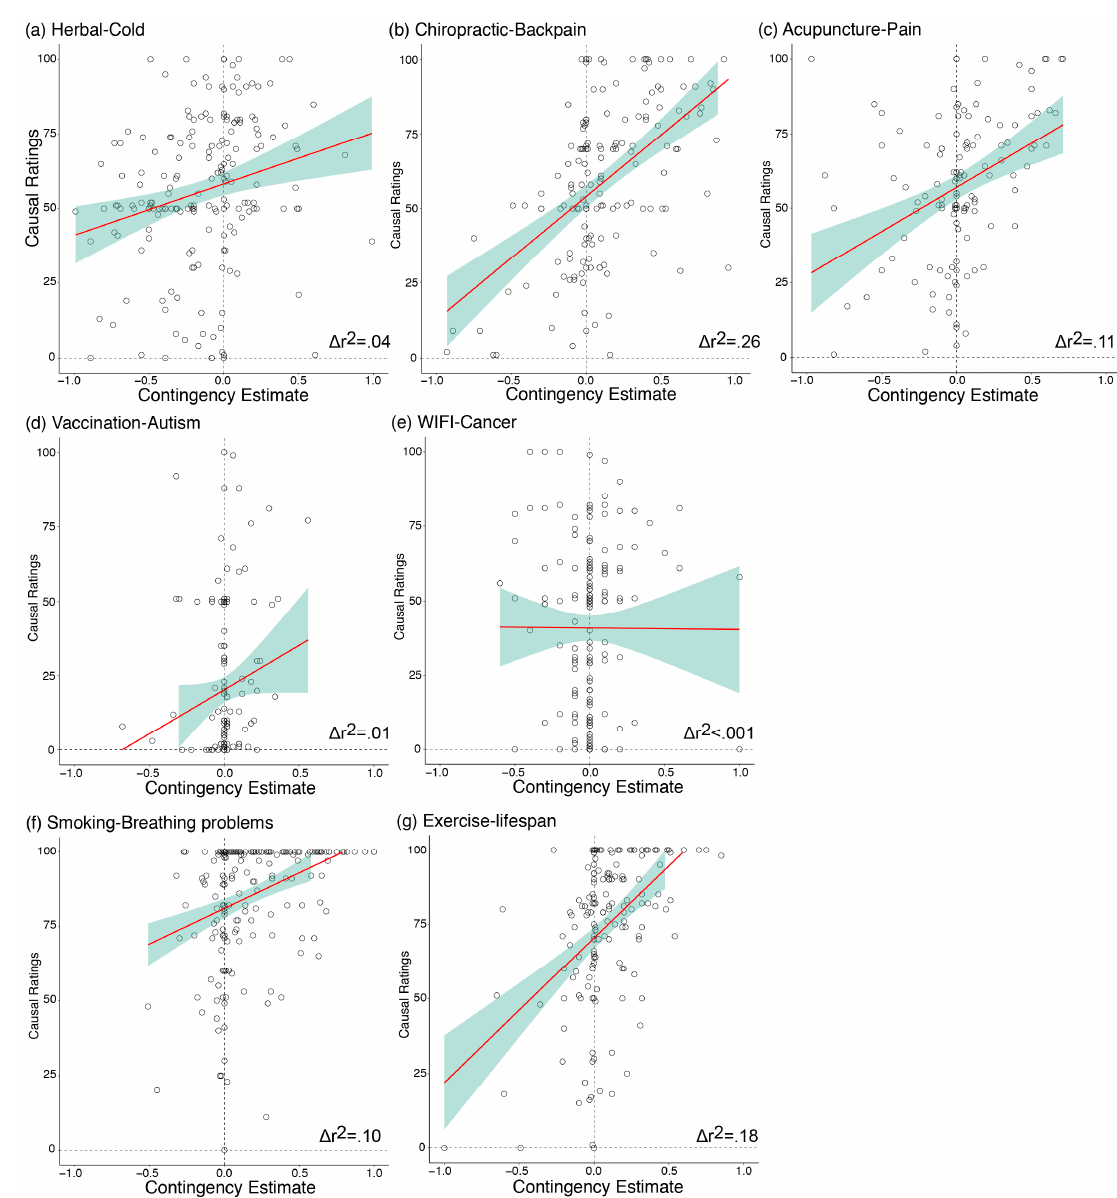
Figure 3. Scatterplot with regression line for each individual participant’s causal belief rating (standard error shaded in green) as a function of the calculated contingency estimate ( ∆ p ) across all topic areas. A significant relationship between the two factors was found for all topics with the exception of vaccination–autism (Figure 3d) and WIFI–cancer (Figure